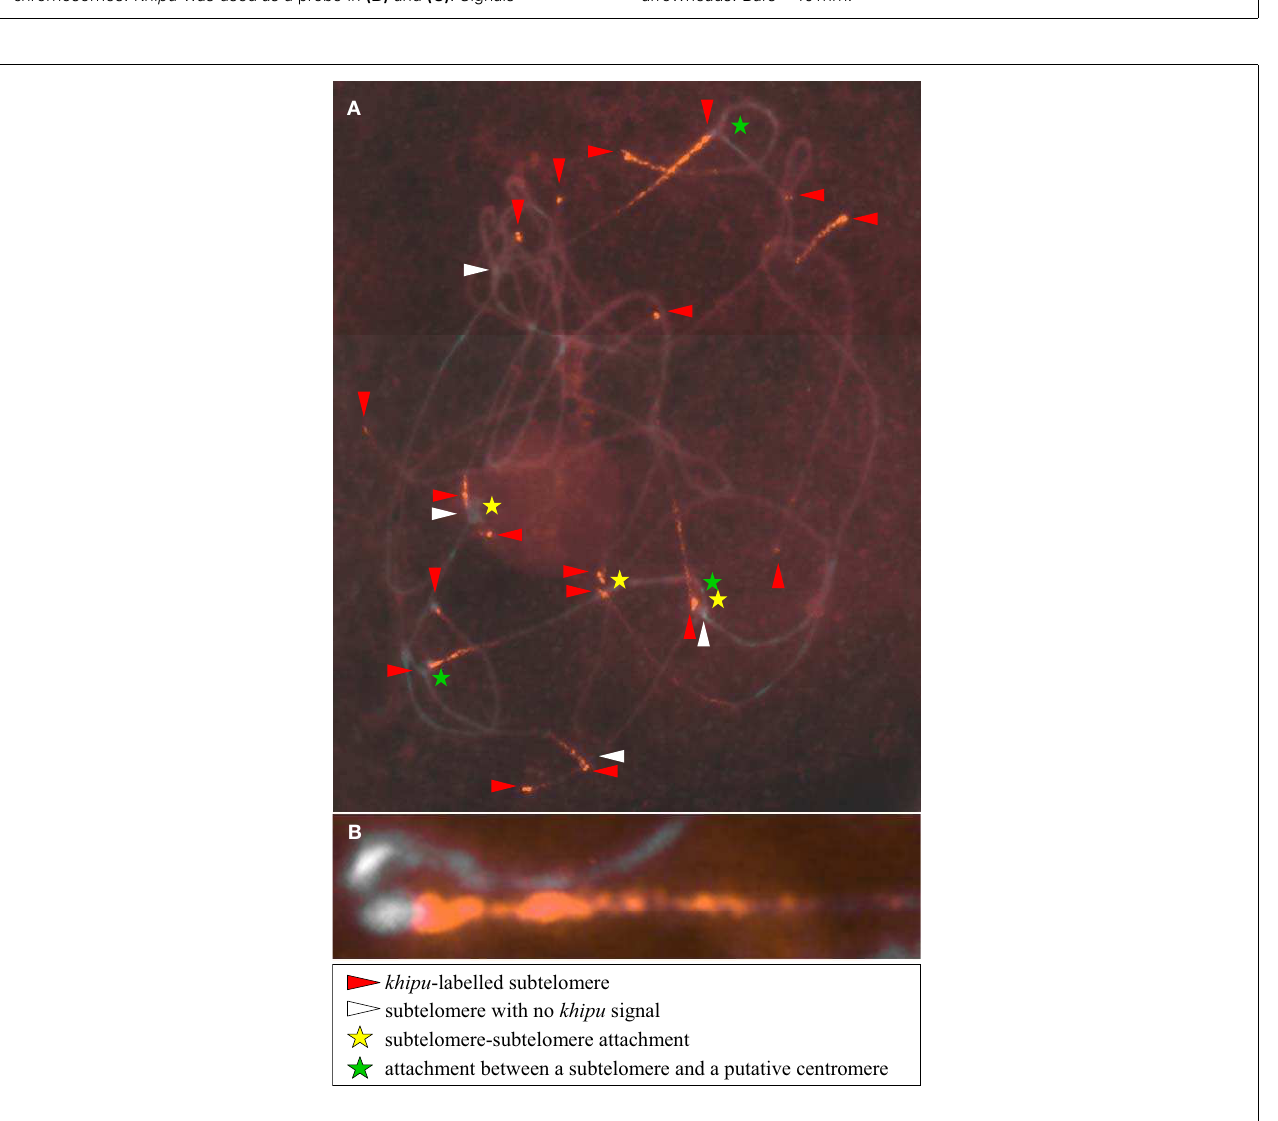
or without khipu labeling are indicated by red or white arrowheads, respectively. Stars indicate putative chromosome attachments. (B) Magnified view of an attachment between two non-homologous